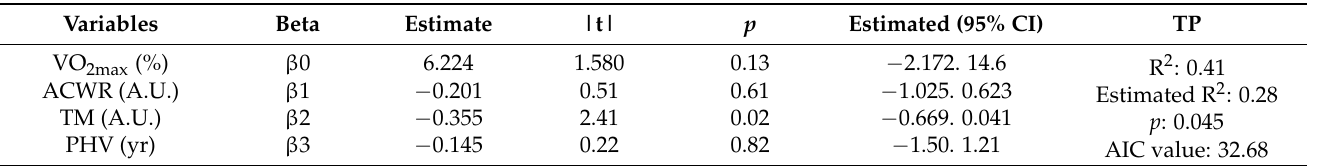
Table 5. Percentage of change in aerobic power with workload and PHV using multiple linear regression